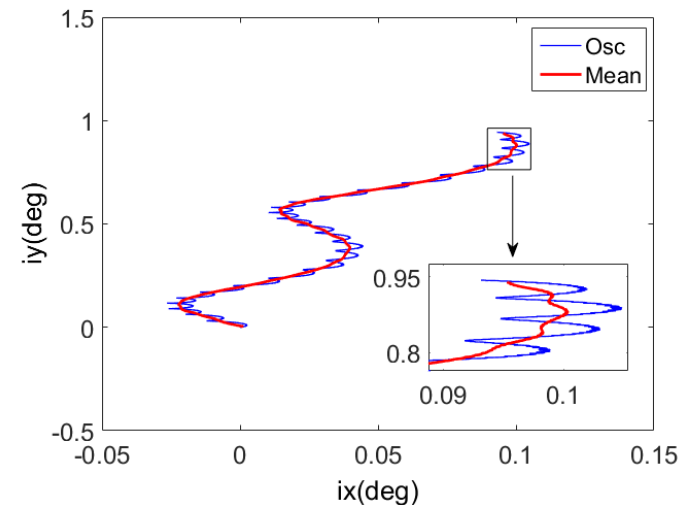
Figure 2. Mean orbital inclination vector under the influence of the semi-annual period term.